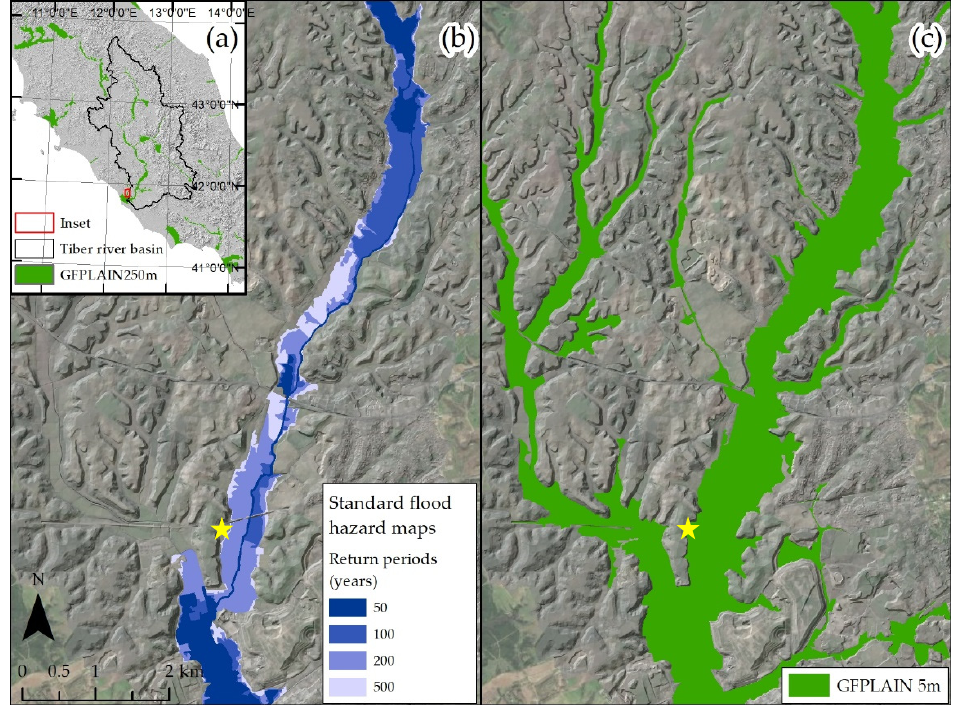
Figure 1. Representation of the GFPLAIN dataset ( c ) compared to a standard flood hazard dataset ( b ) in a small basin (Rio Galeria) tributary of the Tiber River ( a ) (central Italy). Basemaps of ( b ) and ( c ) panels are given by a superposition of satellite imagery and DEM-based hill-shading. The yellow star in panels ( b ) and ( c ) indicate the position of a critical area (oil refinery deposit settled in a floodplain area) outside the available flood hazard map.